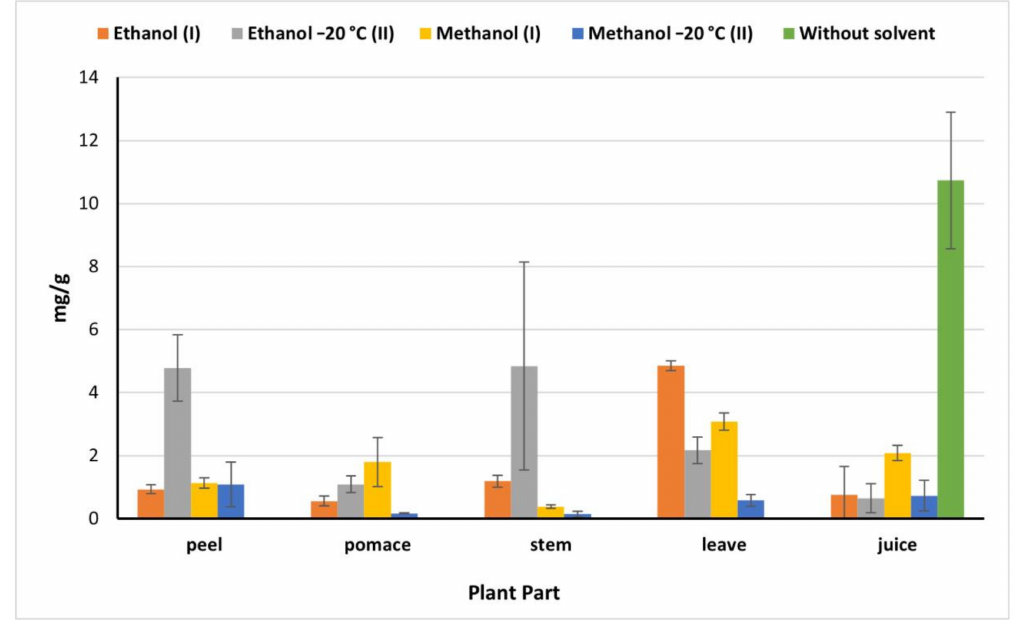
Figure 3. Total flavonoids of beetroot extract (mg catechin / g) based on the dry weight; (I): IEM; (II): OEM at − 20 ◦